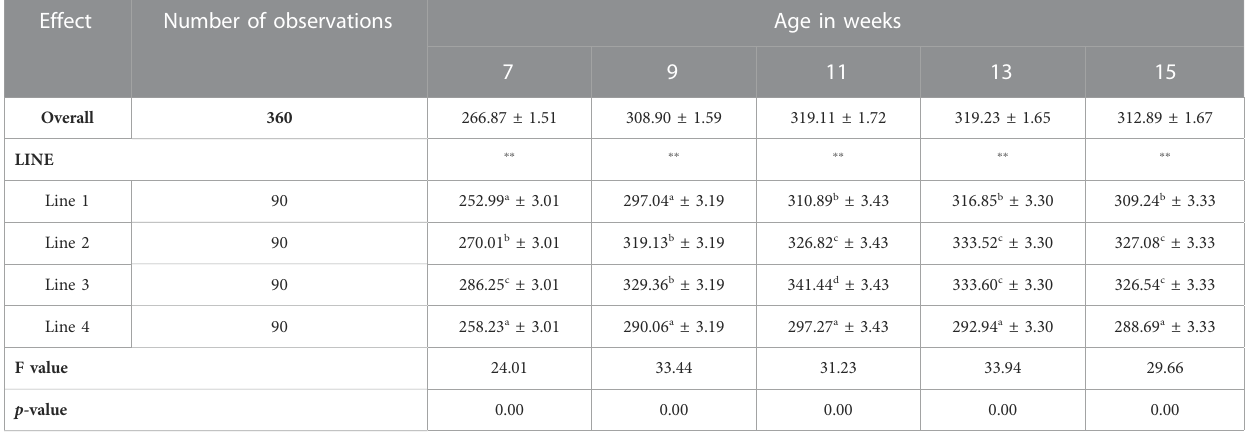
TABLE 3 Means (±S.E.) of body weight (g) of different lines of Japanese quail layers from 7th to 15th week of age.